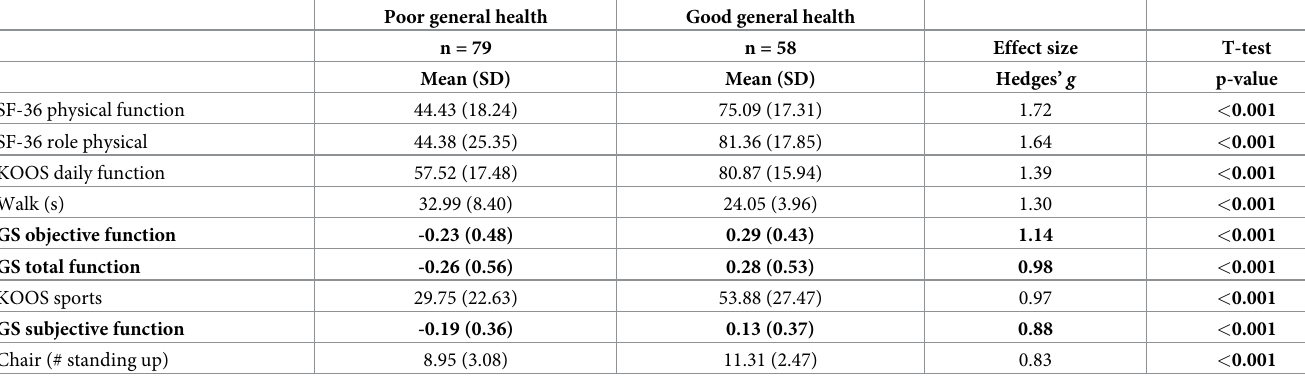
final model had a higher adjusted R 2 : 0.314. For the final models with GaitSmart 1 domains instead of individual GaitSmart 1 parame- ters as independent variables, see S2-S4 Tables in S2 File. Final adjusted R 2 for each model were comparable to the ones found with individual GaitSmart 1 parameters as determinants. II. Differentiation between groups with different general health status. Table 3 shows the results of t-tests and effect sizes in the poor and good general health group. All individual Table 3. Effect sizes of different functional outcome measures in subgroups based on general